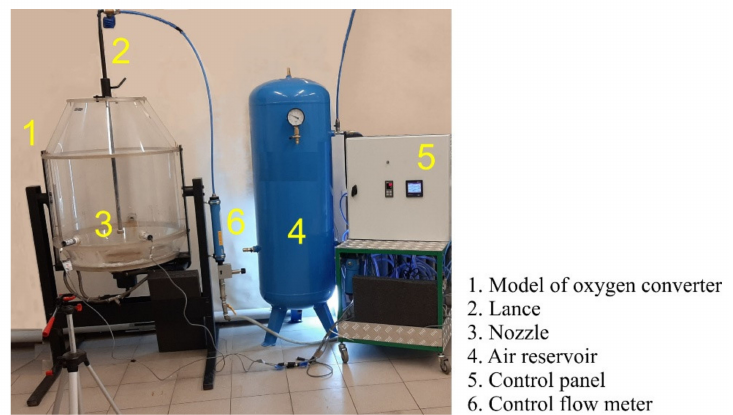
Figure 8. View of the physical model of oxygen